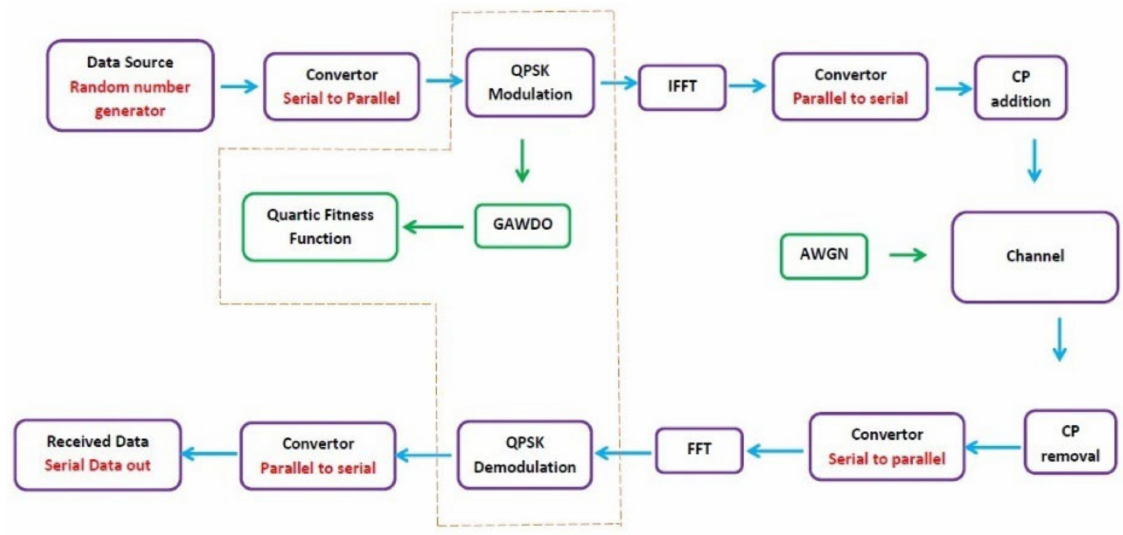
Figure 3. OFDM network sub-blocks and flow